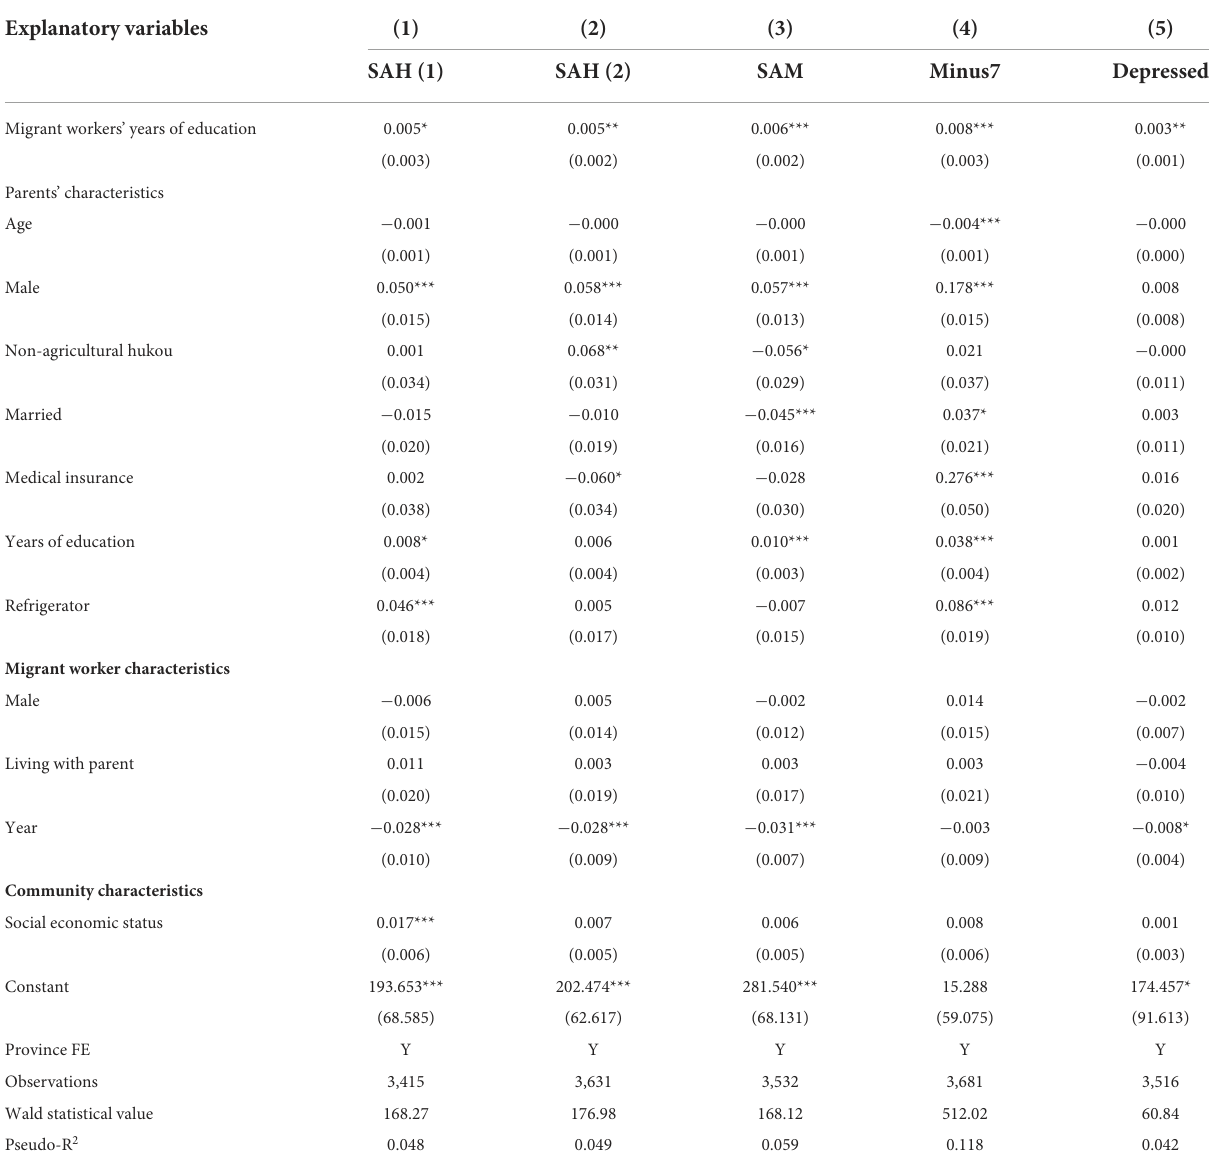
TABLE 2 Benchmark model